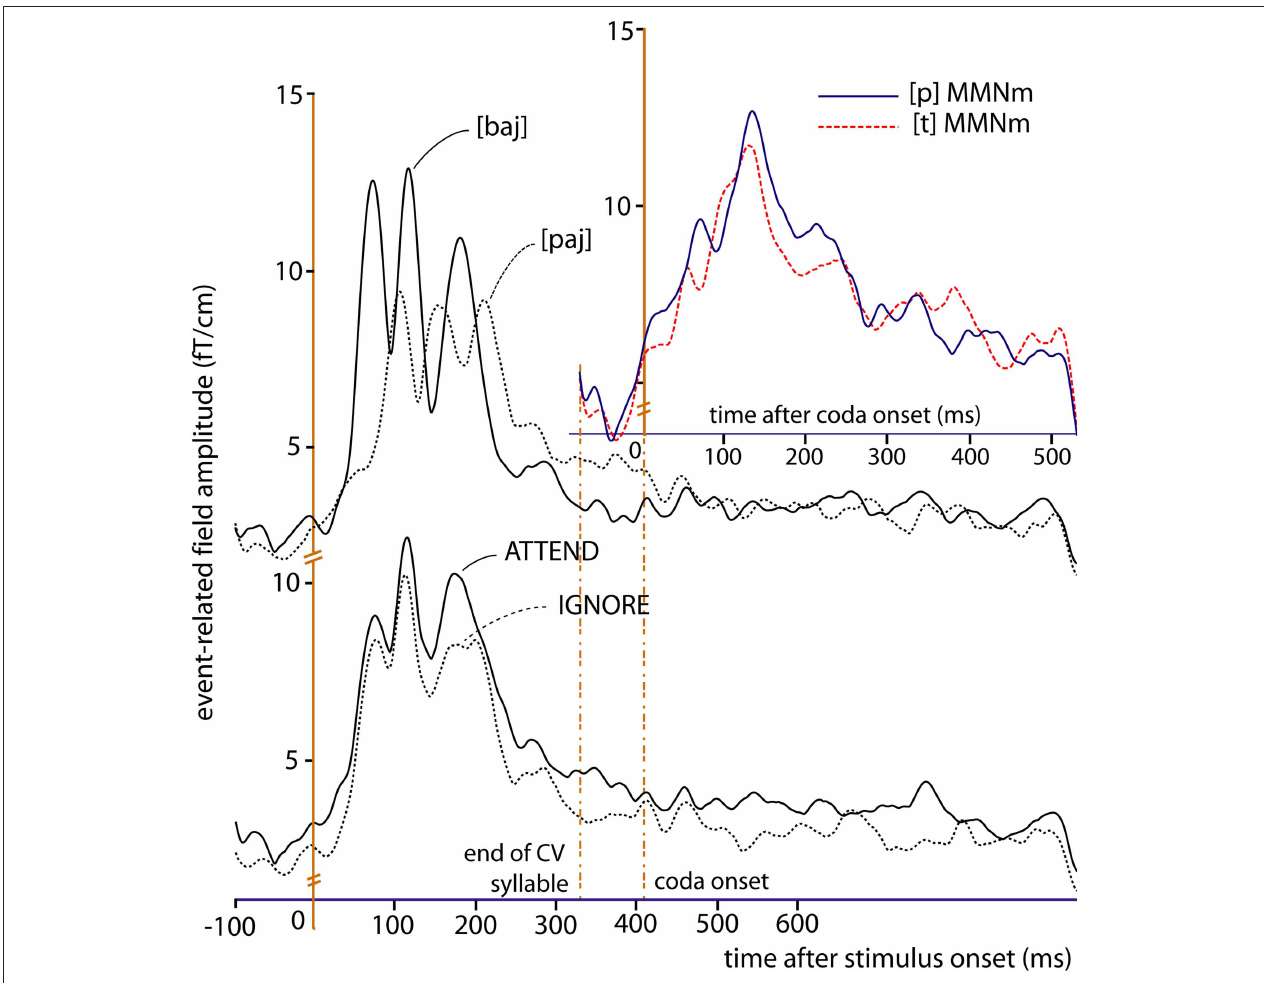
FIGURE 5 | Magnetic brain responses to standard (in black) and deviant stimuli (in blue and red). The local gradient vector amplitudes are plotted. Top-left: responses to standard stimuli ([baj], [paj]) averaged across conditions; note the absence of differences during the MMN main-peak window (120–150 ms